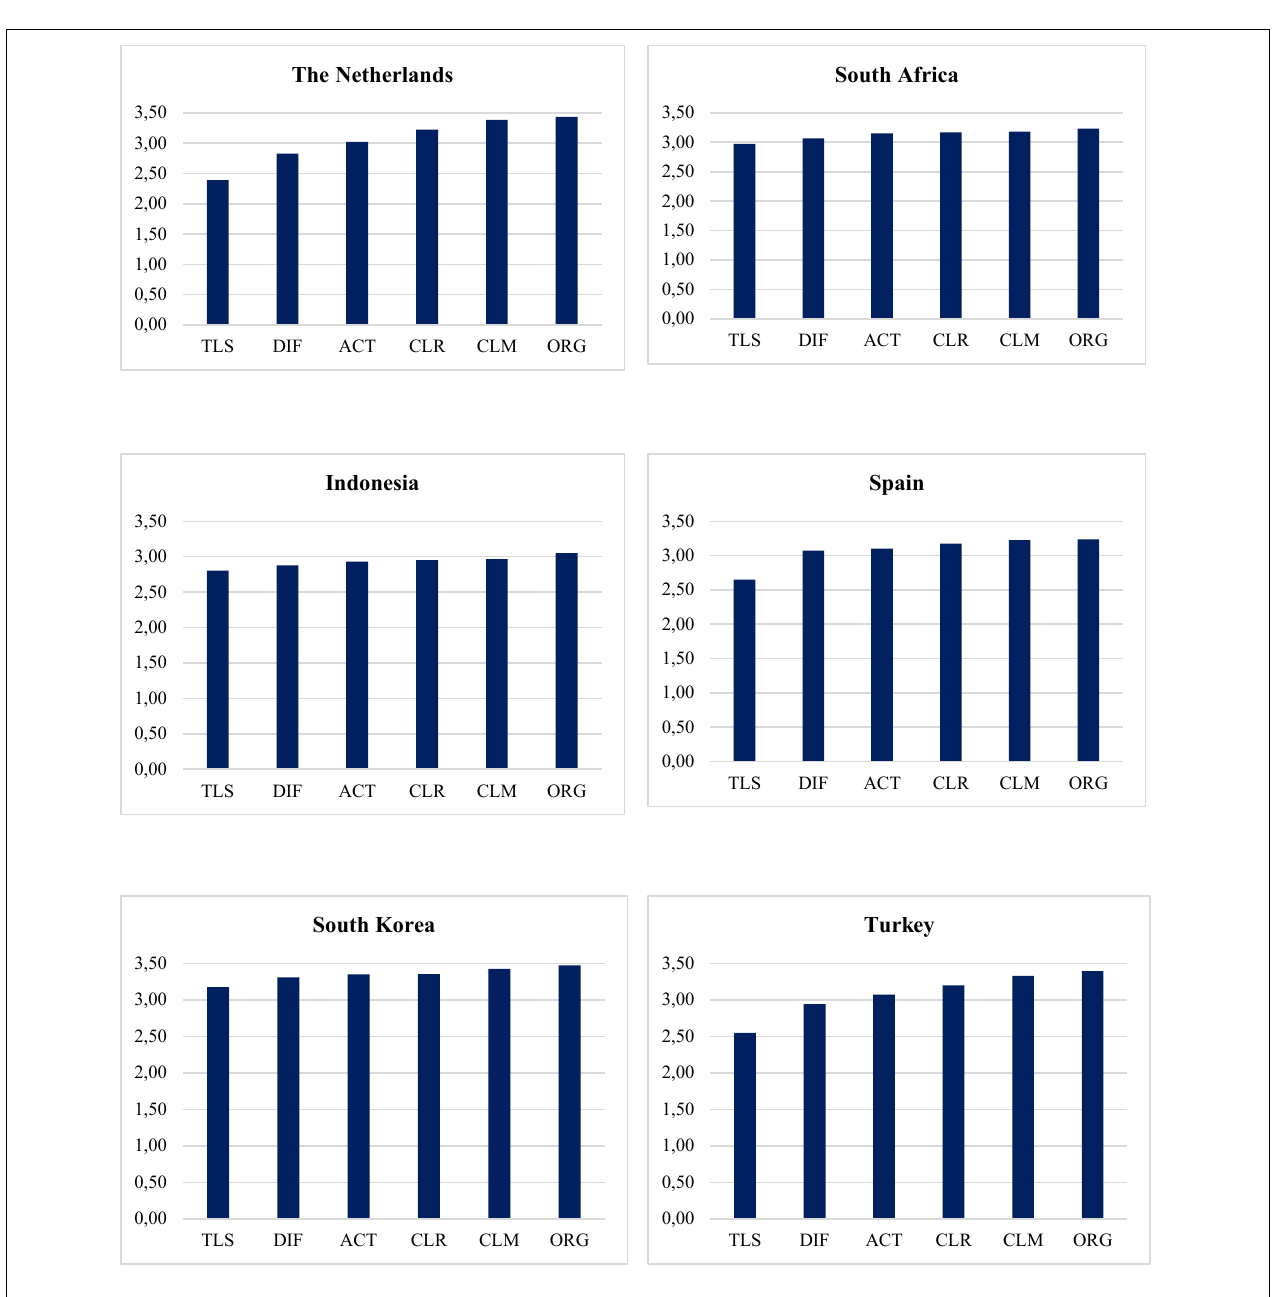
FIGURE 1 | Mean (raw scores) of teaching behavior domains across countries. **CLM = Learning Climate, ORG = Classroom Management, CLR = Clarity of Instruction, ACT = Activating Teaching, DIF = Differentiation, TLS = Learning Strategies.